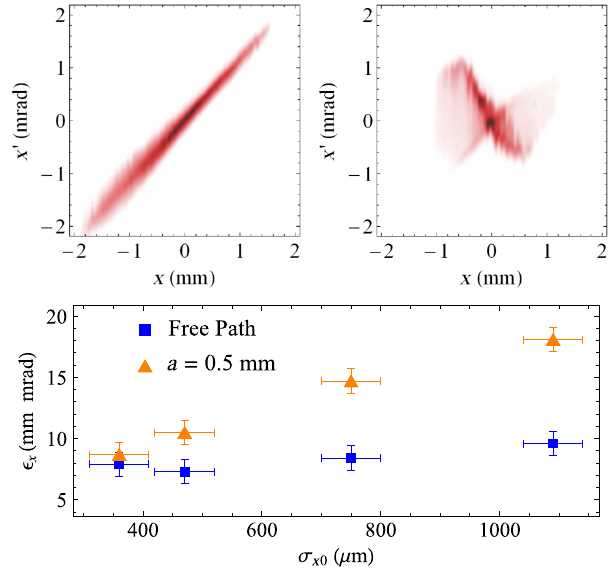
FIG. 5. Top: horizontal phase spaces of the beam with σ x 0 ¼ 0 . 75 mm propagating in the free path (left) and through the structure set to a ¼ 0 . 5 mm (right). Bottom: dependence of the horizontal projected emittance on beam size σ x 0